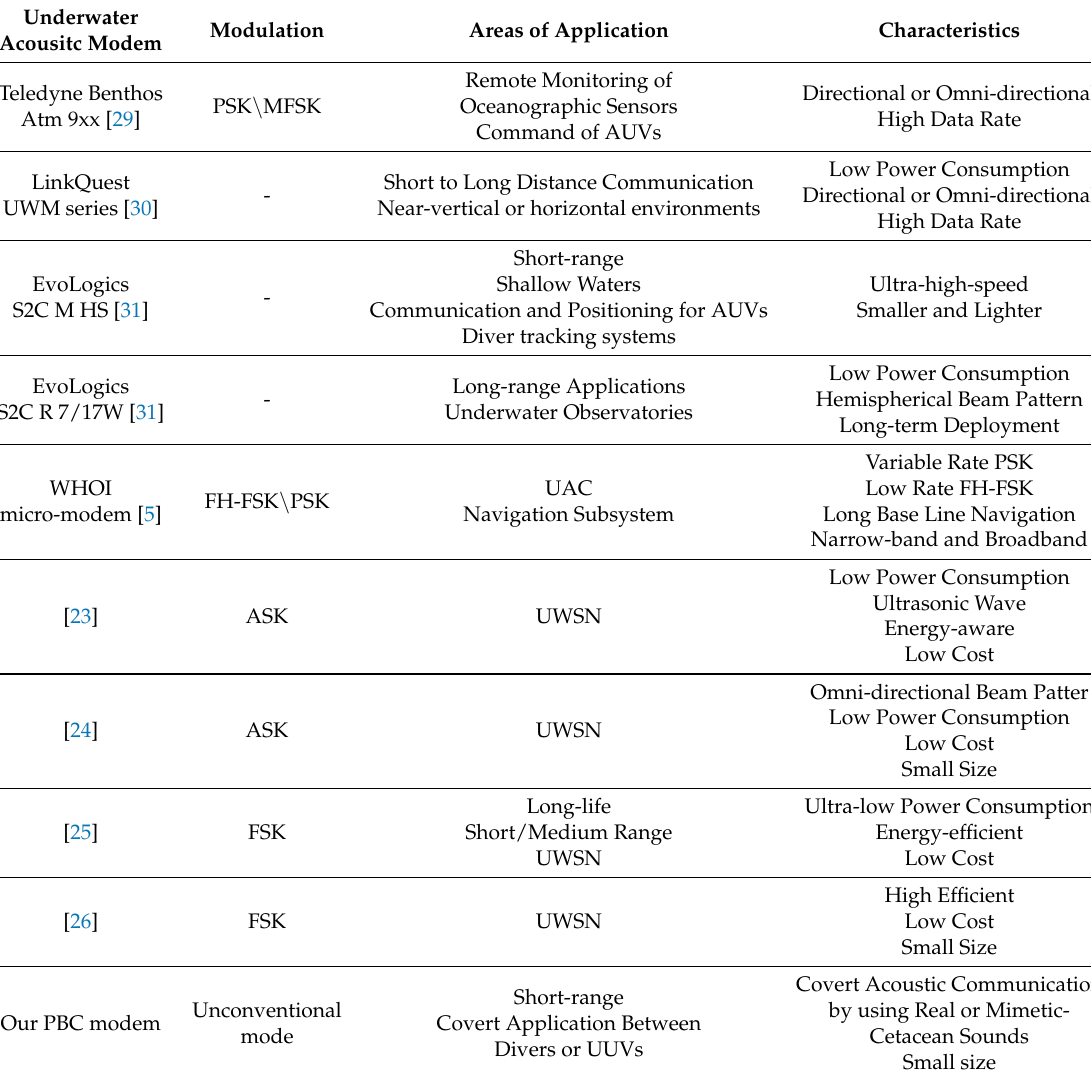
Table 1. Comparison of developed devices, commercial devices and the Portable Biomimetics-based Covert (PBC)